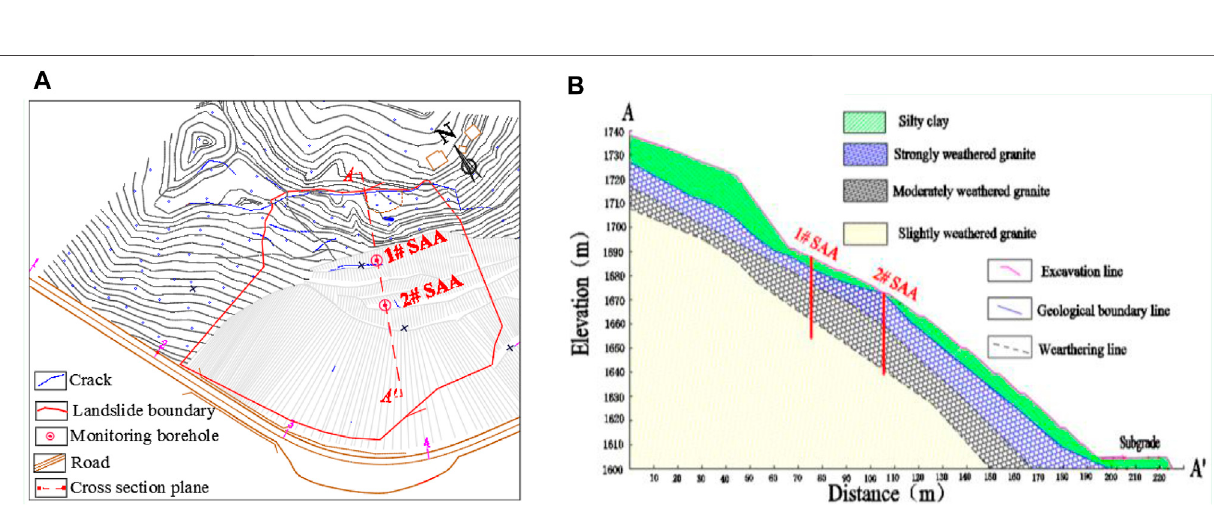
Frontiers in Earth Science |